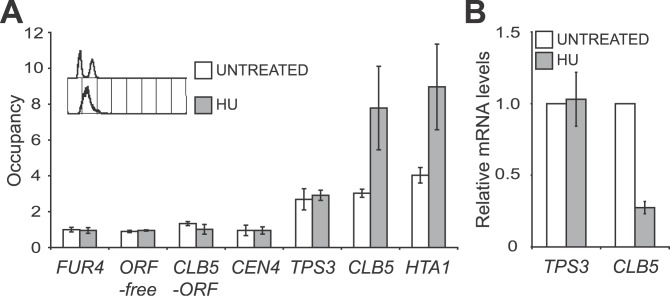
Transcriptional Regulation of CLB5 by RSC(A) RSC association with the CLB5 and HTA1/HTB1 promoters is increased upon HU treatment. Strains were exposed for 3 h to HU (150 mM) at 30 °C. Cross-linked chromatin was immunoprecipitated using IgG beads (see Materials and Methods), and recovery of indicated fragments was assessed by quantitative PCR. Recovery is shown as fold over the average of RSC occupancy at the FUR4 promoter (which does not bind RSC, [27]) and at an ORF-free region on Chromosome I (positioned between YAR053W and YAR060C, [27]). Typically, recovery ranged between 0.1%–0.3% of input for the CLB5 promoter. The DNA profiles of cells upon harvesting are shown as an inset. Values are the average of three independent experiments using an STH1TAP allele and standard deviations are indicated.(B) RSC functions as a repressor of CLB5 expression. Expression levels of the RSC targets CLB5 and TPS3 were assessed using quantitative PCR in HU-treated cells and untreated cells. Data are normalized to total RNA concentrations, as well as to the expression levels of these genes in untreated cells and represent the average of three independent experiments.